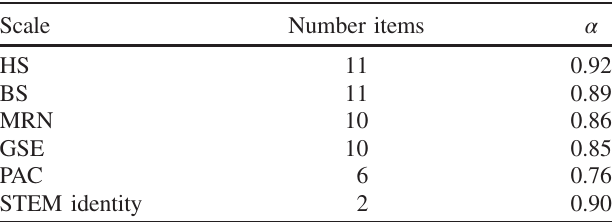
TABLE I. Final Cronbach alphas of the scales used in the study.